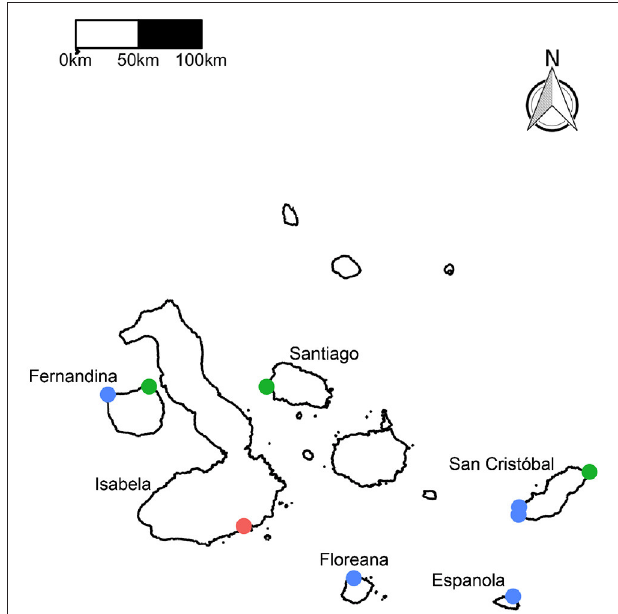
FIGURE 1 | Map of the nine study sites in the Galápagos Islands. Benthic surveys were performed at all nine sites. Survey only sites are blue, grazing assay sites are green, and the experimental site is